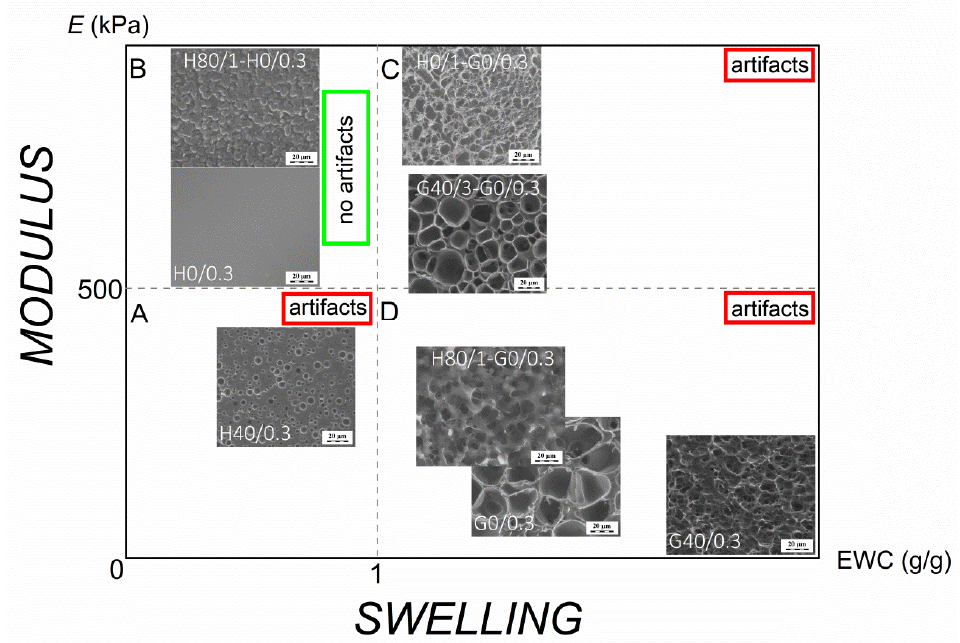
Figure 7. A cryo-SEM “map” of studied non-porous hydrogels: Young’s modulus ( E ) vs. equilibrium water content (EWC). water content